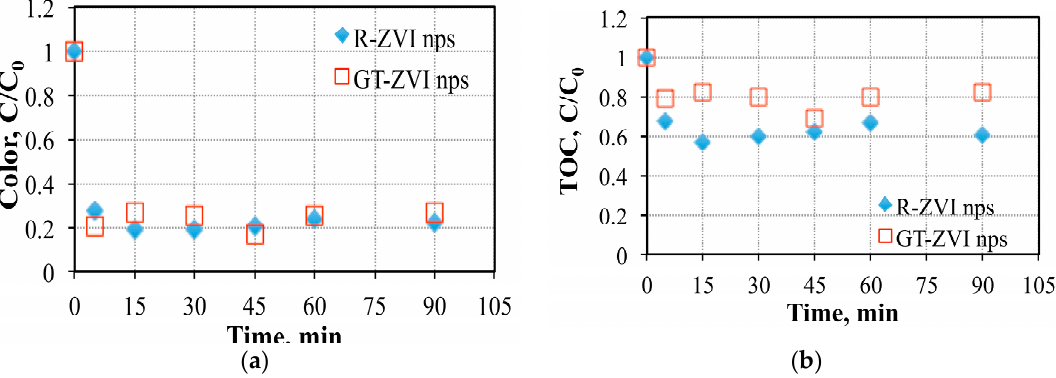
Figure 5. Color and TOC removal with ( a ) GT-ZVI nps (0.01 M, pH: 3, 2/1) and ( b ) R-ZVI nps (0.1 M, pH: 3,